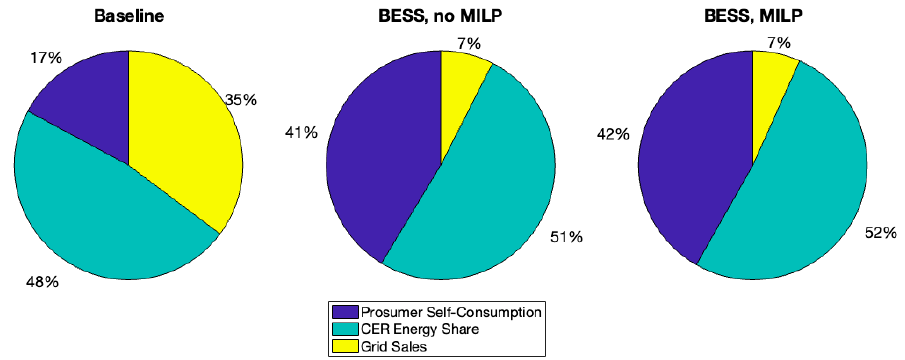
Figure 11. PV energy usage report for the three considered scenario.